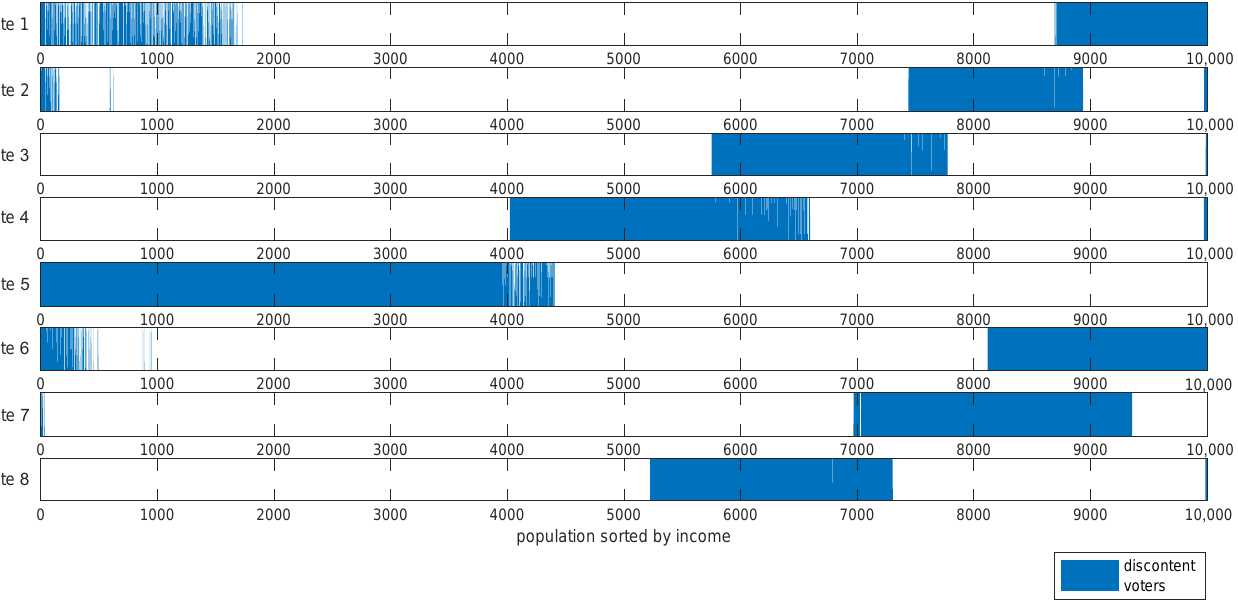
Figure 10. Individual discontent in a sequence of eight recursive mandates (from top to bottom). η wf = 1.0, ξ = 0.0. Mandate length: 4 years. Voters income advantage exigency